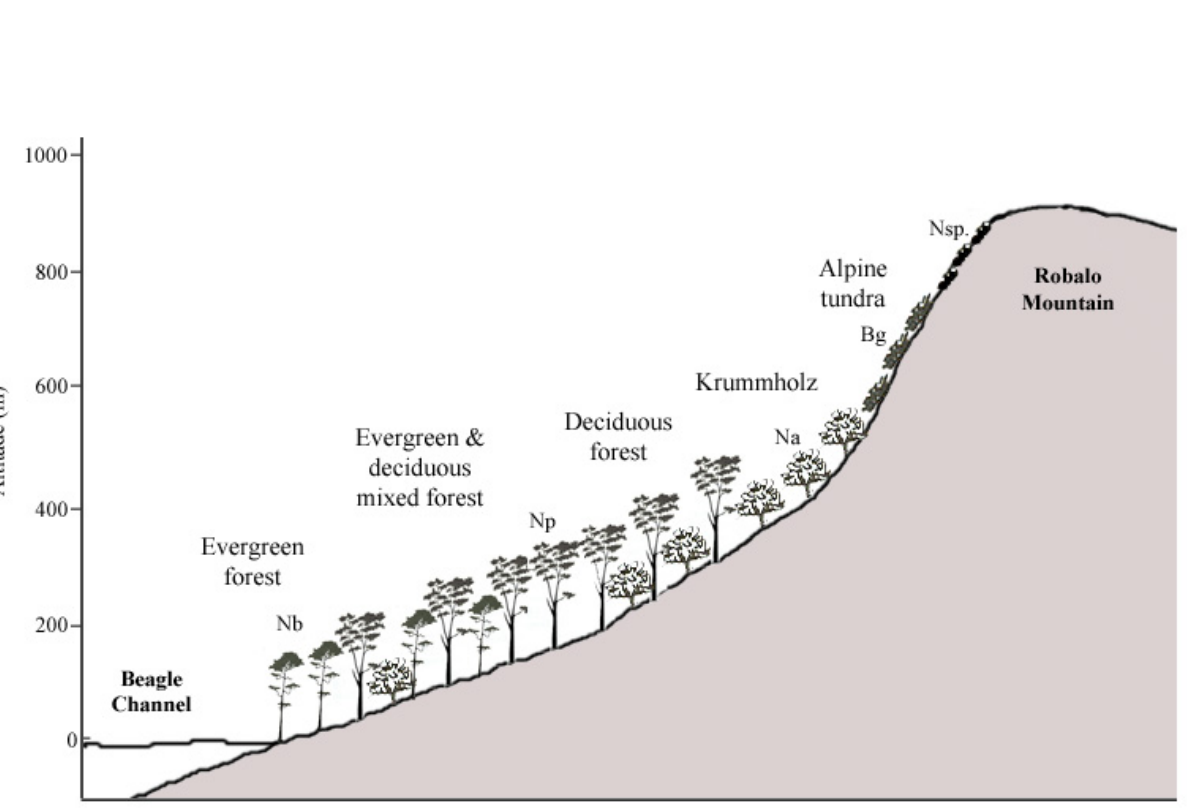
Fig. 2. The Omora Park extends 920 m from the Beagle Channel to the summit of Robalo Mountain. This altitudinal gradient includes the characteristic habitat types of the Cape Horn region. From the shoreline upwards these habitats are: evergreen forests dominated by Nothofagus betuloides (Nb); mixed evergreen-deciduous forests dominated by N. betuloides and N. pumilio (Np); deciduous forests dominated by N. pumilio and N. antarctica (Na); alpine tundra dominated at lower levels by cushion plants, e.g., Bolax gummifera (Bg); and at upper levels by lichens ( Neuropogon sp. (Nsp). For an illustration of these habitat types see Appendix